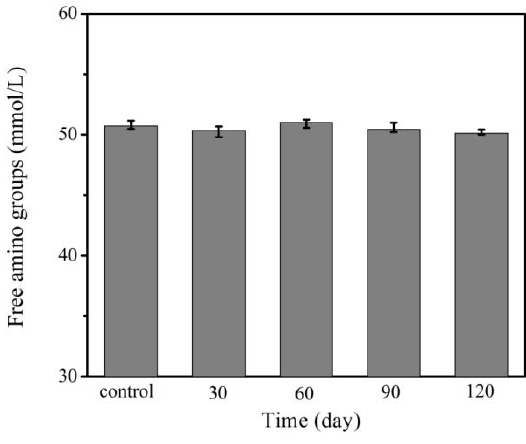
Figure 6. Effect of frozen storage time on the free amino group content of the wheat